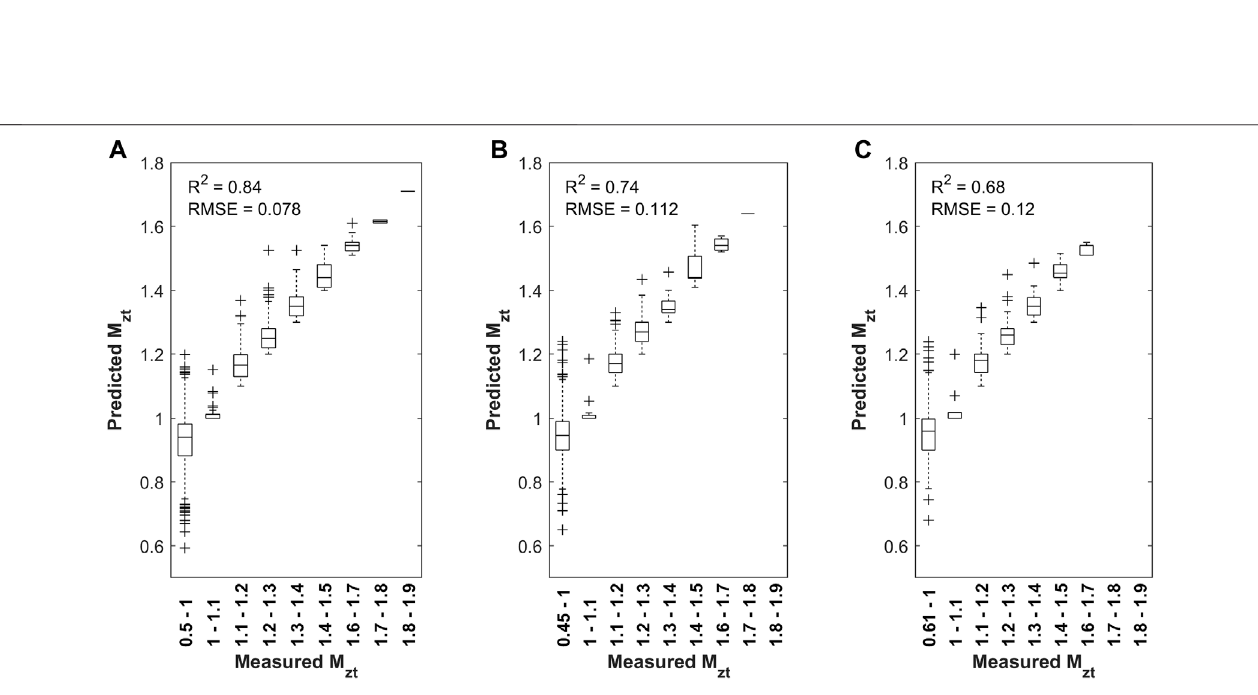
Frontiers in Built Environment |